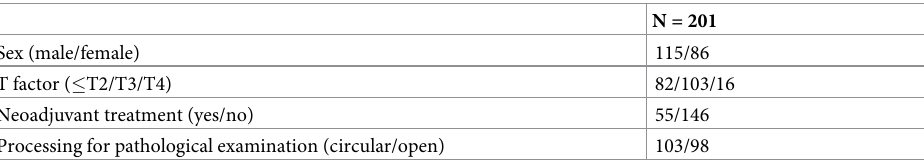
Table 1. Summary of the analyzed